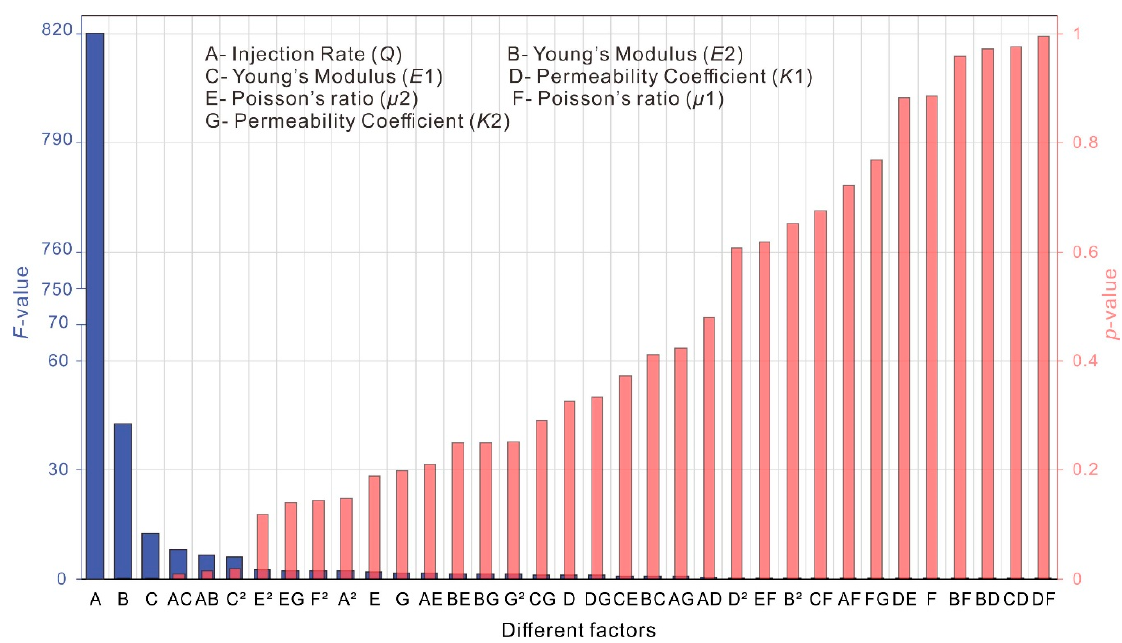
Figure 9. Statistical significance of variables and their joint action to SRV.